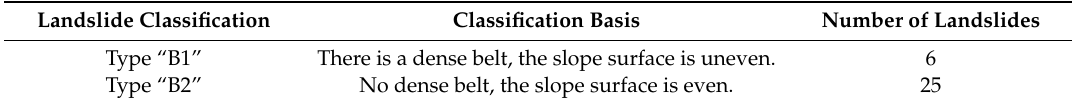
Figure 8. Slope with a significant dense zone. Table 3. Classification of landslides.